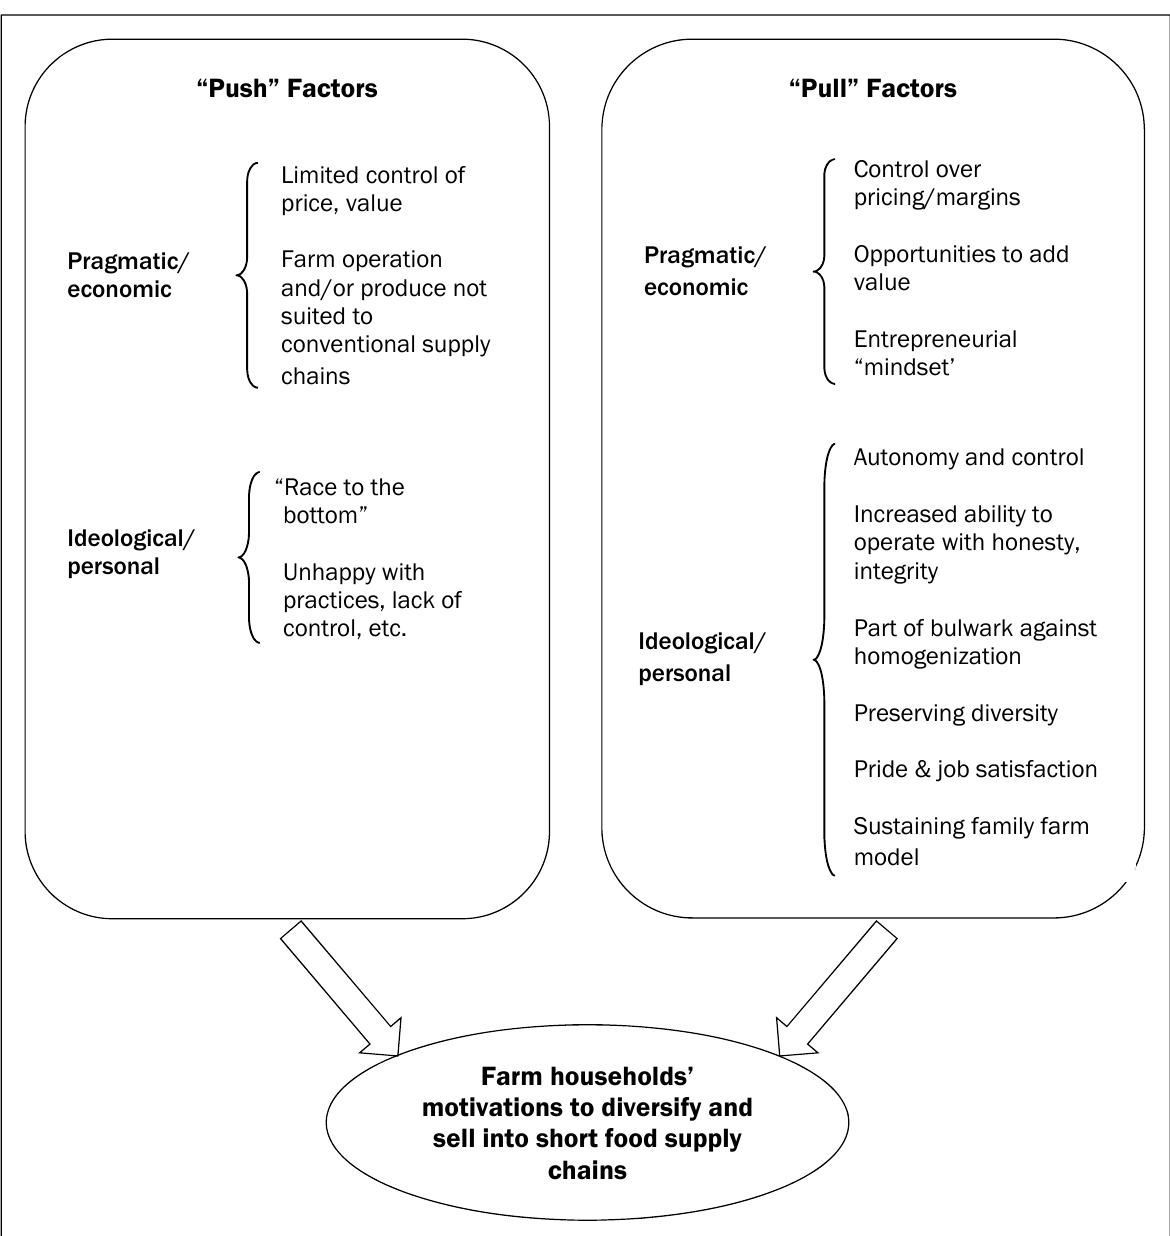
Figure 2. Summary of Motivations to Diversify and Sell into Short Food Supply